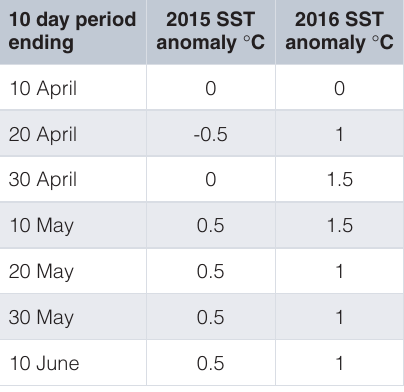
Table 3. Sea surface temperature anomalies in the weeks preceding the bleaching event on Nata Reef and a similar time interval in 2015. Values are the degrees in centigrade above the 30 year average for this site in each time interval. Data from the Japan Meteorological